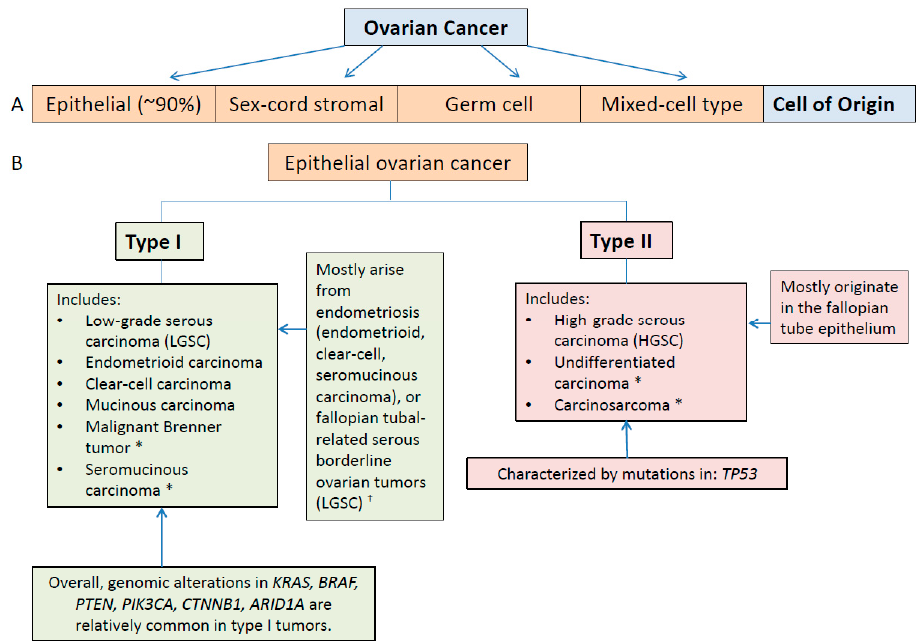
Figure 2. ( A ) Histological subtypes of ovarian cancer; and ( B ) widely accepted epithelial ovarian cancer classification paradigm based on clinicopathologic and molecular evidence that type I and type II tumors develop through different pathways (Kurman et al. [18]). * Indicates rare tumor; † Mucinous and malignant Brenner tumors are considered to be possible exceptions that may arise from transitional cells at or close to the junction of the fallopian tube and the peritoneum.